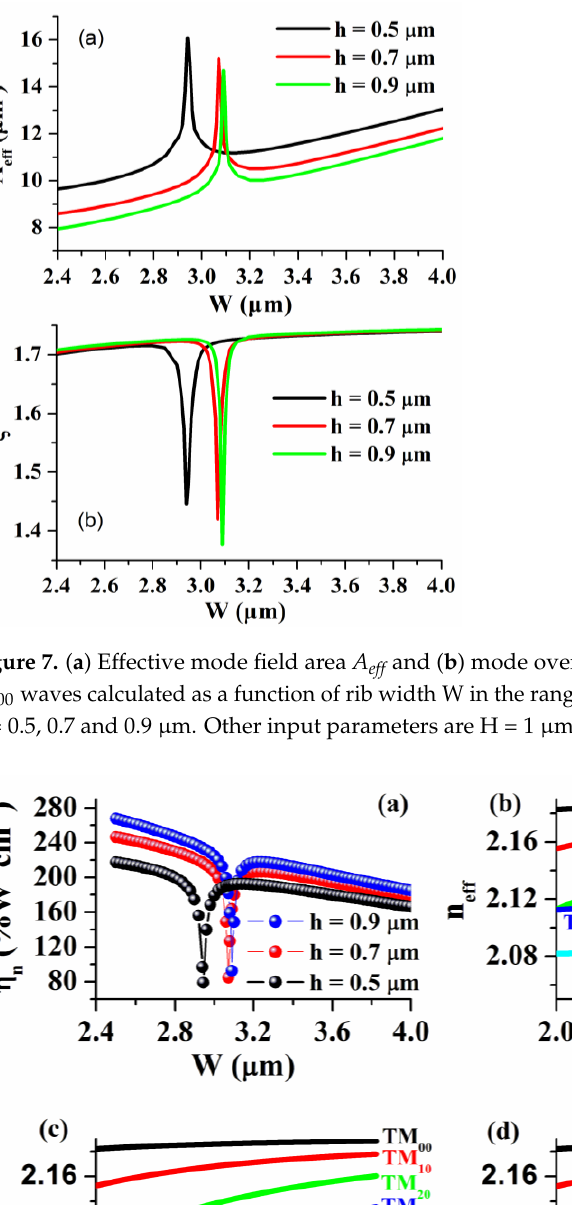
Figure 7. ( a ) Effective mode field area A eff and ( b ) mode overlap factor ζ of pump, signal and idler TE 00 waves calculated as a function of rib width W in the range of 2.4–4.0 µm for different rib heights h = 0.5, 0.7 and 0.9 µm. Other input parameters are H = 1 µm, α = 78° and λ = 3.3 µm.